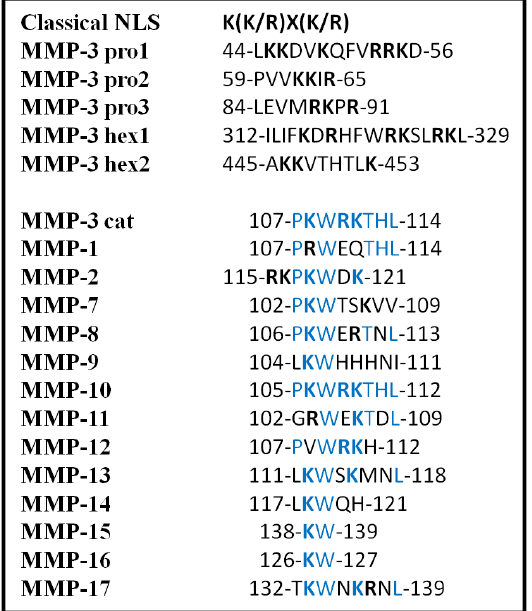
Figure 2. Nuclear localization sequences found in human MMP proteins. The consensus sequence for the classical NLS is indicated at the top of the figure. Three NLSs from the MMP-3 pro-domain (pro1-3) and two NLSs from the hemopexin-like domain (hex1-2) are highlighted. The NLS from the catalytic domain of MMP-3 is shown as a reference sequence, for comparison purposes with putative NLSs from the catalytic domains of other MMPs. Similar or identical sequences within the aligned NLSs are indicated with blue.